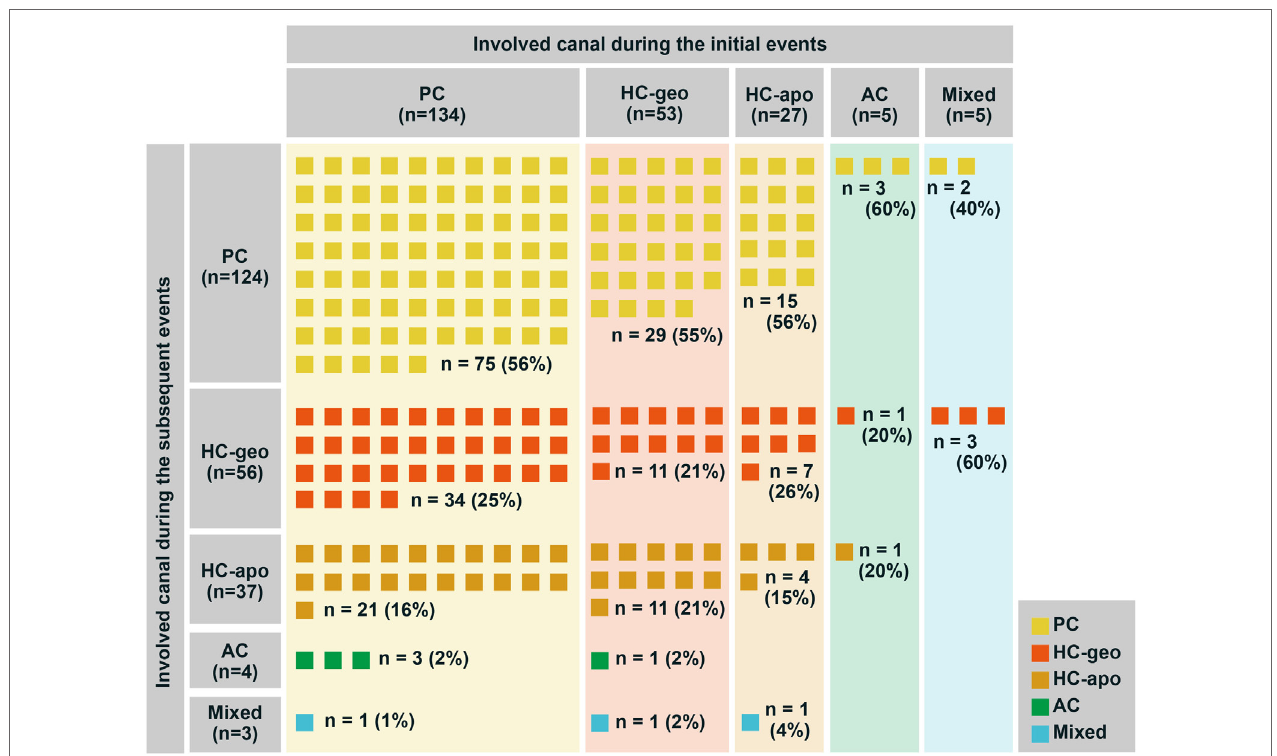
FigUre 3 | The types of benign paroxysmal positional vertigo (BPPV) during recurrences. Irrespective of the types of BPPV during the initial attacks, the proportion of BPPV types showed no difference during the following attacks (Chi-square test, p = 0.9738). AC, anterior canal; HC-apo, apogeotropic horizontal canal; HC-geo, geotropic horizontal canal; PC, posterior